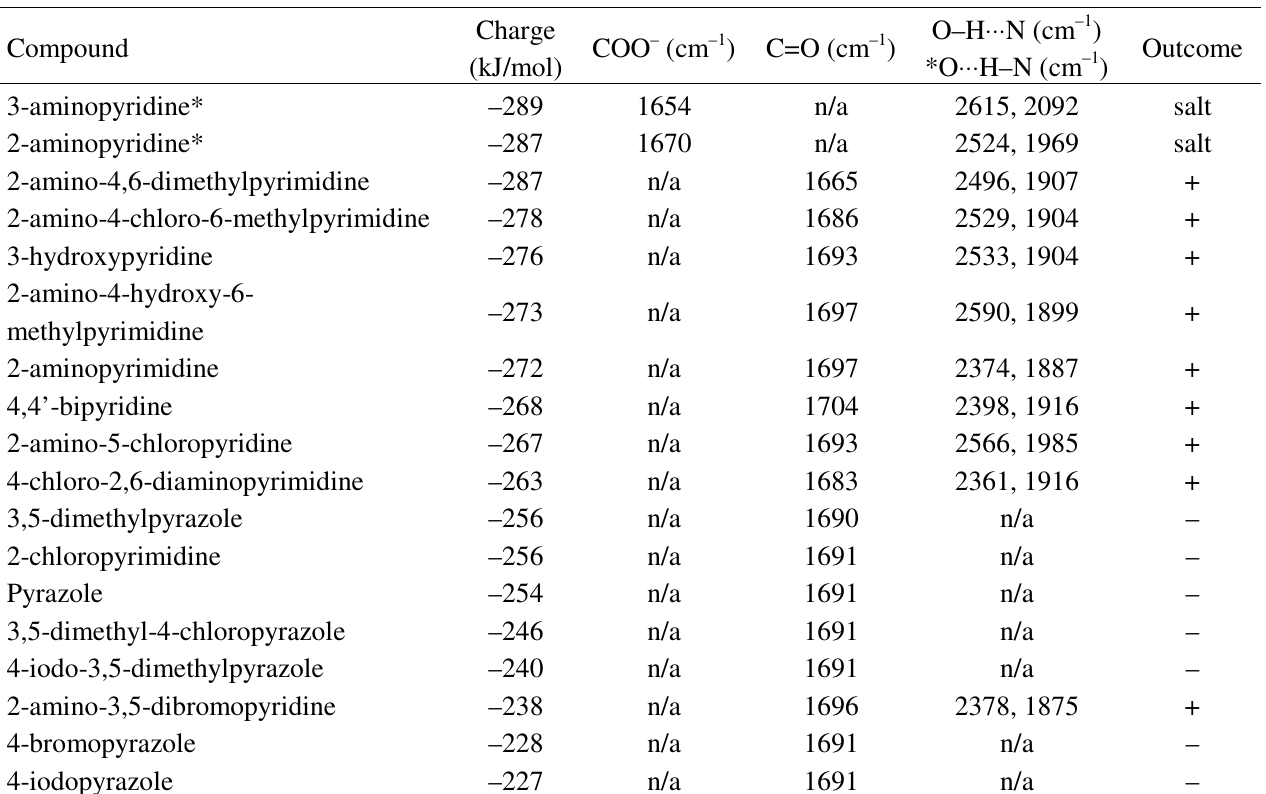
Table 1. Co-Crystal Screening